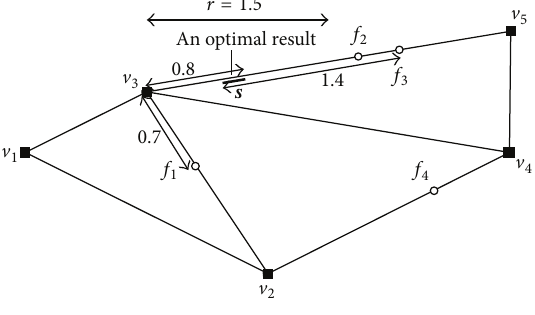
Figure 3: MaxRS query in road